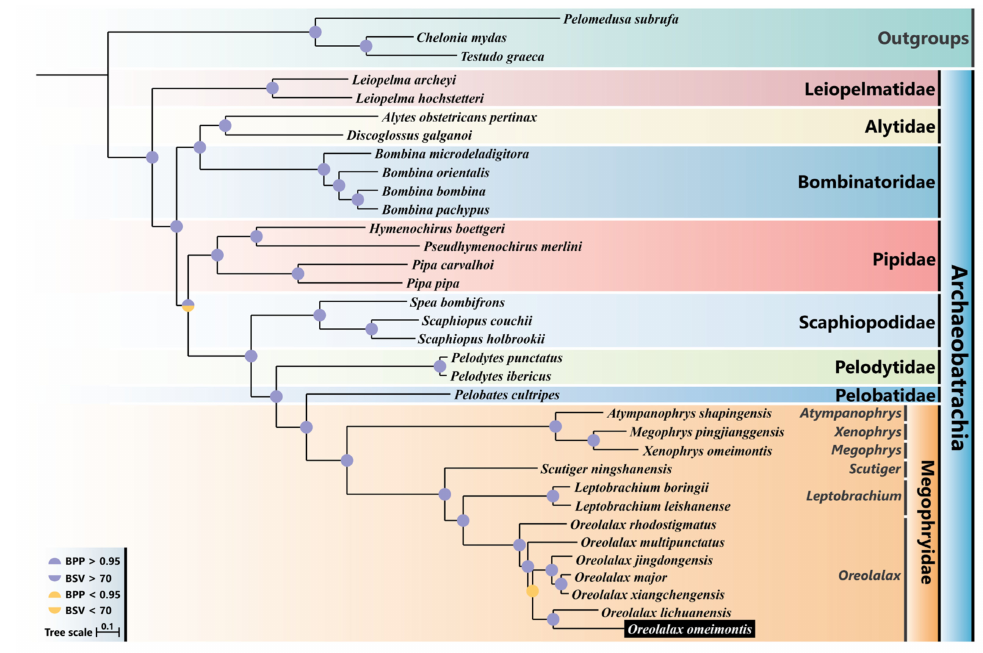
Figure 4. Phylogenetic tree of the Archaeobatrachia species based on the concatenated nucleotide sequences of 13 PCGs using maximum likelihood (ML) and Bayesian inference (BI) analysis. The semicircle on the upper of each node represents the Bayesian posterior probability (BPP), while the lower semicircle represents the bootstrap value